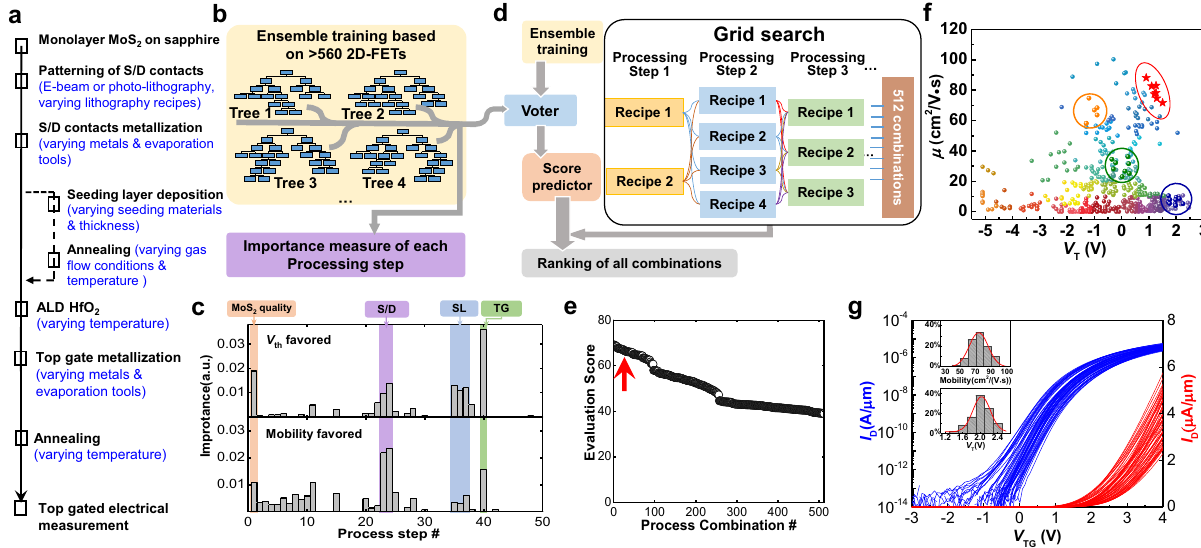
Fig. 2 Machine learning assisted optimization of MoS 2 -device process. a Process fl ow for fabricating TG MoS 2 FETs. The variations in each step are marked in blue. b Graphical representation of ensemble learning (EL) based on decision-tree algorithm. The importance of each processing step is extracted during the creation of decision trees. c Importance of processing steps for μ and V T based on random-forest regression, where S/D, SL, and TG represent the source/drain contacts, the seeding layer, and the top gate. d Diagram of co-optimization procedure based on ML. After training with EL, a score predictor can predict the overall device performance for all processing combinations using a grid-search method. e Ranking of all possible processing combinations. The high-score combinations can be referenced for device fabrication. f More than 500 MoS 2 TG-FETs summarized in a μ – V T plot. Each color corresponds to one process recipe. The red stars are the results of the process recipe in e pointed by the red arrow. The orange, green, and blue points are three batches of devices fabricated for a control experiment discussed in the maintext. g Transfer characteristics for 60 MoS 2 TG-FETs on one wafer at V DS = 0.5 V in linear and logarithmic coordinates. The insets show histograms and Gaussian fi ts (red solid lines) of statistical data for Y-function- calculated mobility (upper) and threshold voltage (downside) to Gaussians.